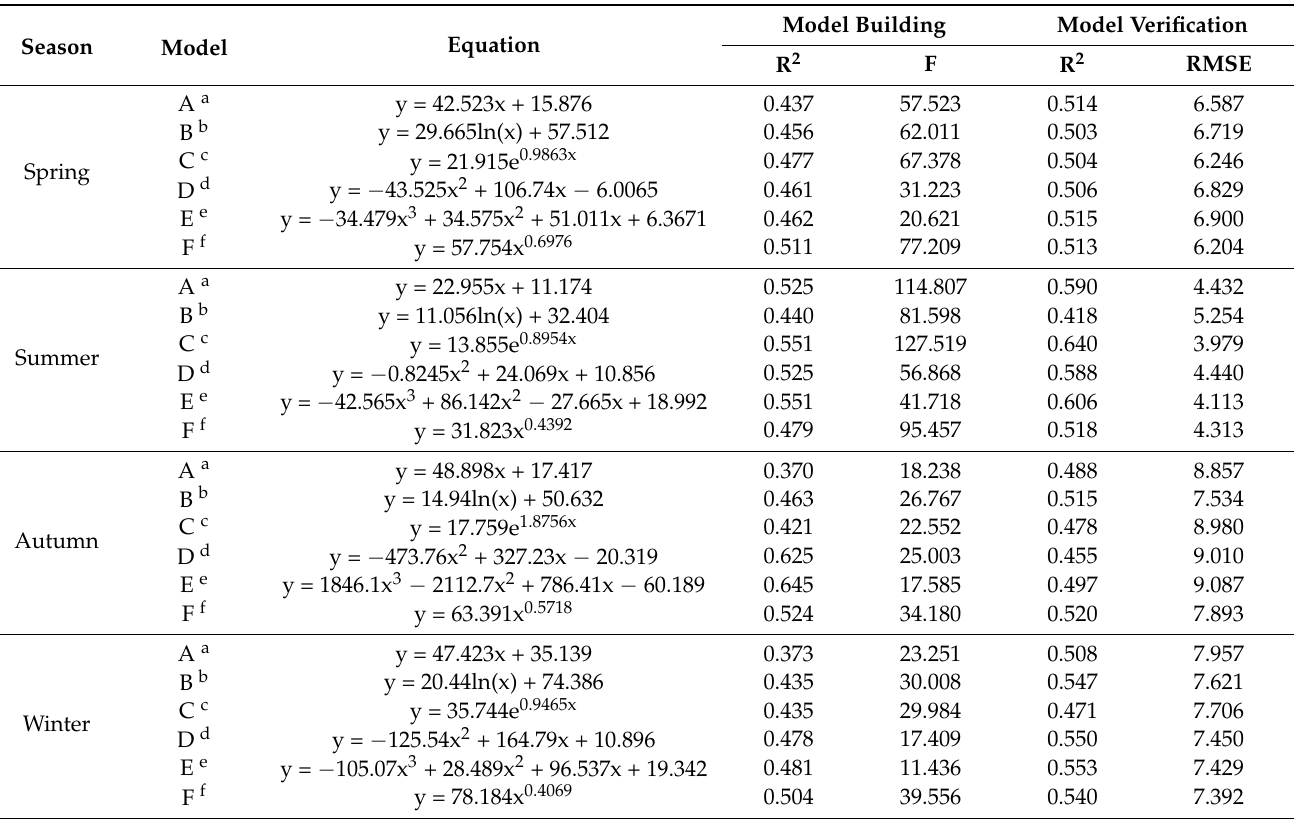
Table 7. Seasonal model building and verification